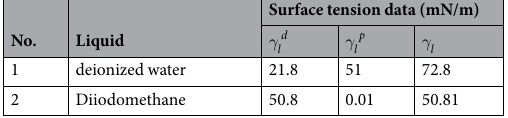
Table 6. Test liquids and their surface tension